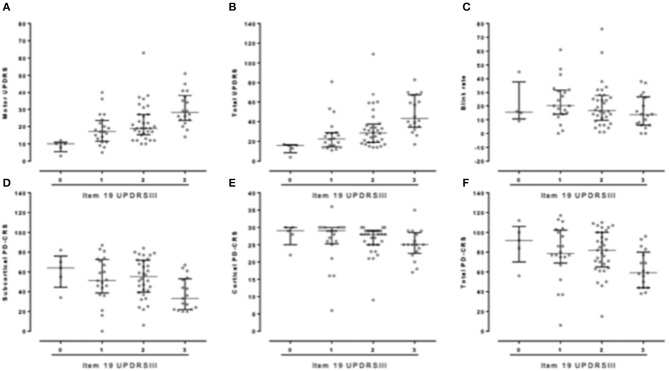
(A,B) Correlation between facial bradykinesia (item 19UPDRS III) and UPDRS (A. motor-UPDRS; B. Total UPDRS). (C) Correlation between facial bradykinesia (item 19UPDRS III) and blink rate at rest. (D–F) Correlation between facial bradykinesia (item 19UDPRS III) and cognitive test. (D) PD-CRS subcortical score; (E) PD-CRS cortical score; (F) Total PD-CRS.